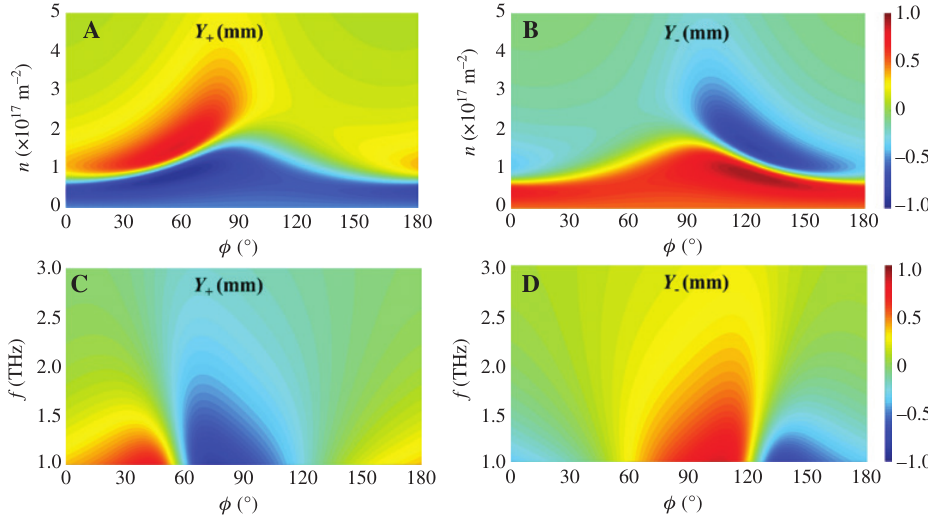
with rotating angle, carrier density and frequency. ± as a function of the rotation angle φ and carrier density n when the incident angle θ = 74.43 ° , f = 1 THz. ± as a function of φ and f . ±